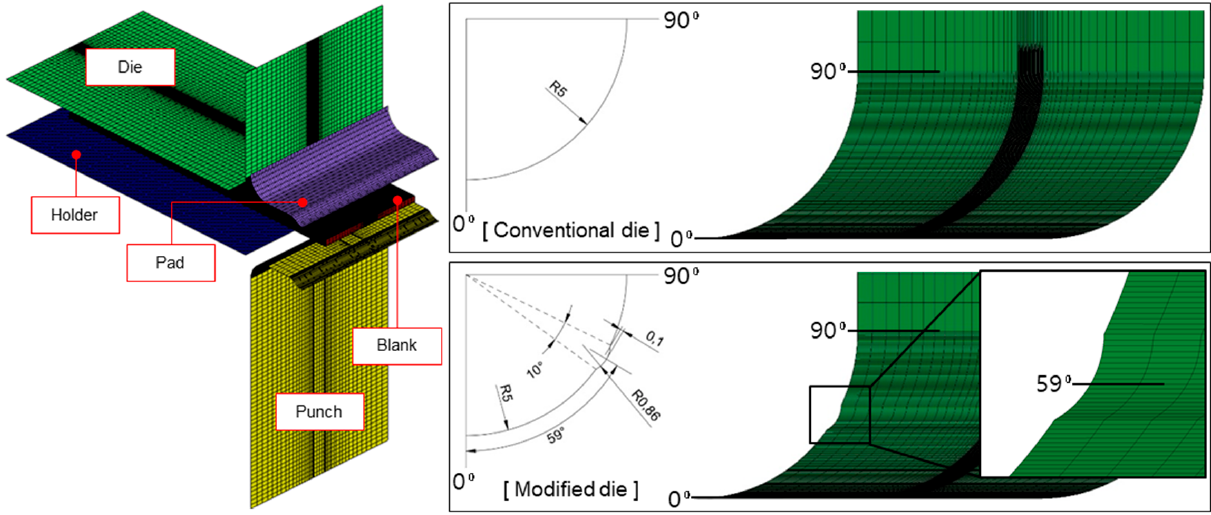
Figure 10. Finite element (FE) modeling for simulating the drawing wear test with the conventional and modified tool dies.